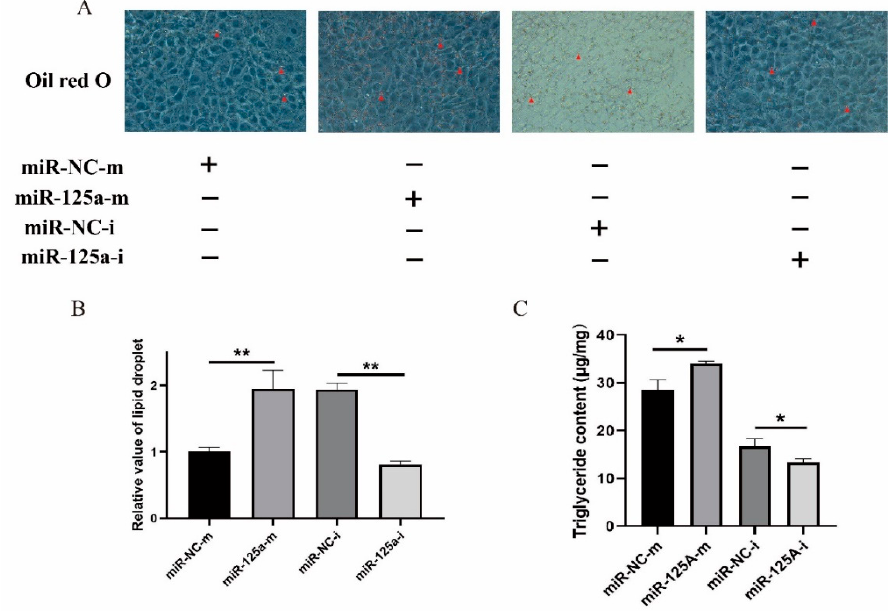
Figure 6. ( A ) Oil red O staining: staining at 72 h after transfection, with microscopic examination; ( B ) Oil red O staining: staining at 72 h after transfection, with quantitative analysis of images; ( C ) Triglyceride production by MAC-T cells after miR-125a-mimic and inhibitor transfection for 72 h. All experiments were performed in triplicate. * Significant difference between the control and the treatment ( p < 0.05); ** Very significant difference between the control and the treatment ( p < 0.01).